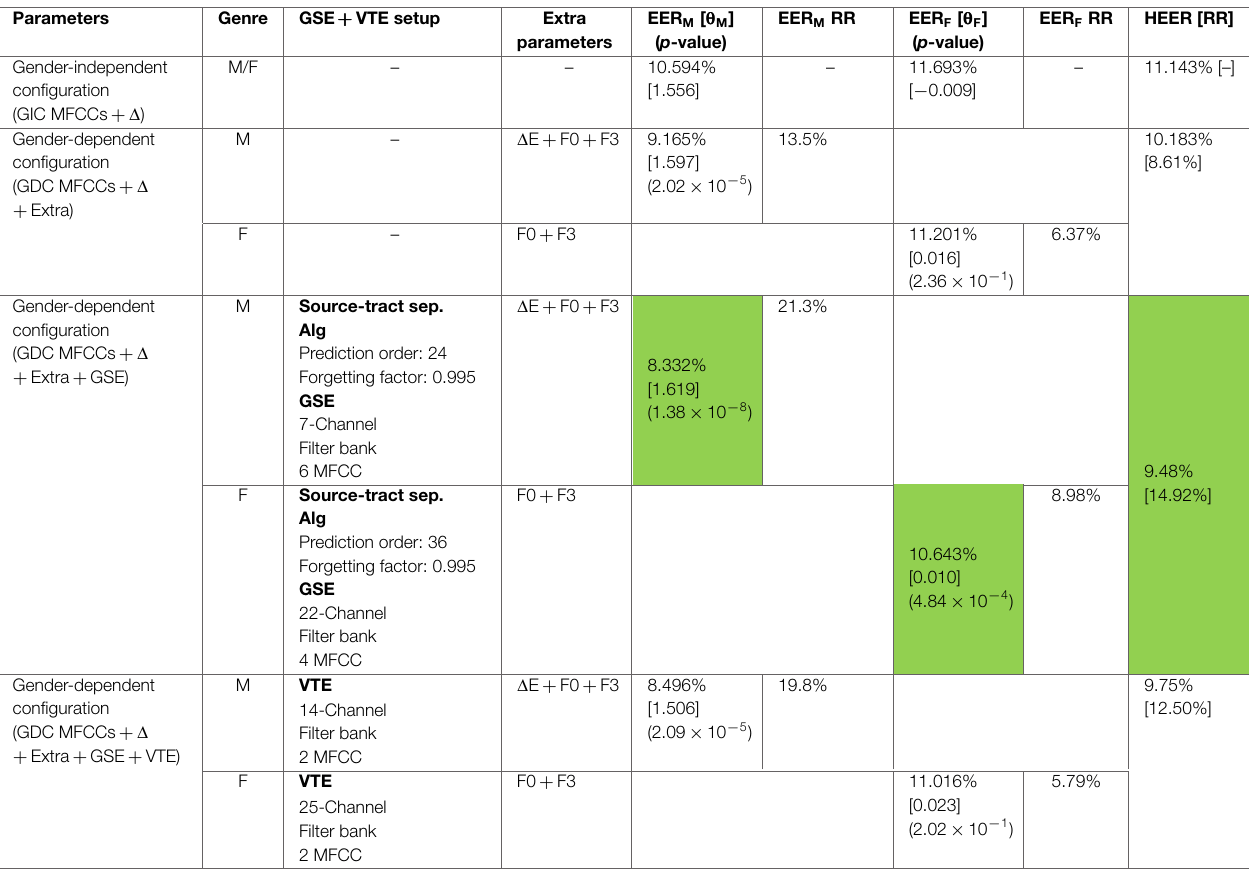
TABLE 6 | EER obtained on development set (ZTNorm – male and NoNorm – female), comparing classical parameters in a gender-independent setup with a gender-dependentsetupinwhichextraparametersandextendedbiometricparametersareincorporated[RR !!! RelativeReduction/[threshold]/( p -value)] .